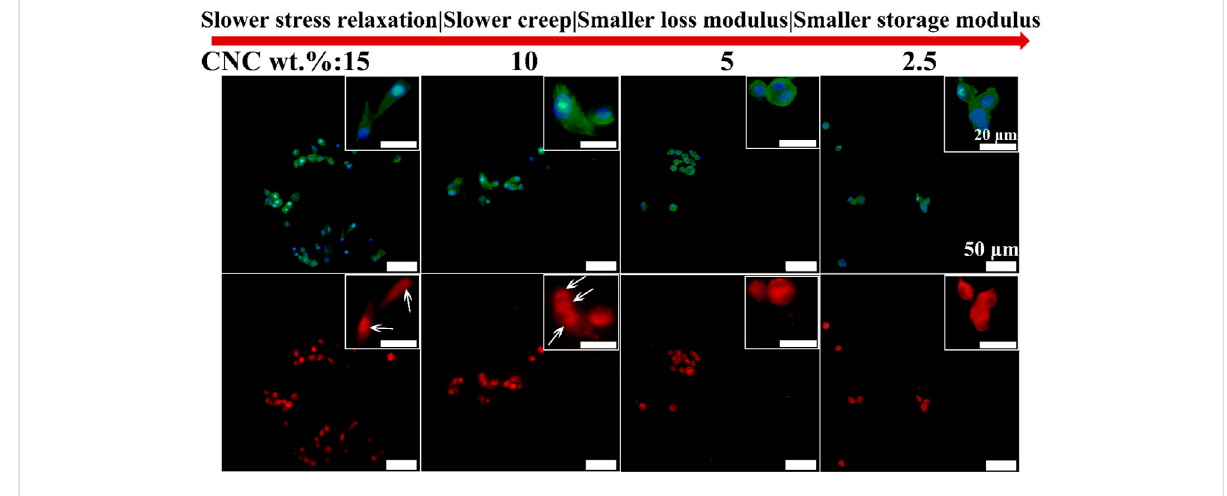
FIGURE 7 FAK staining of chondrocytes cultured in differentviscoelastic hydrogels. Green represents actin staining, blue represents nucleus staining, and red represents FAK staining. Images were taken after 14 days in culture. White arrow indicates the location of